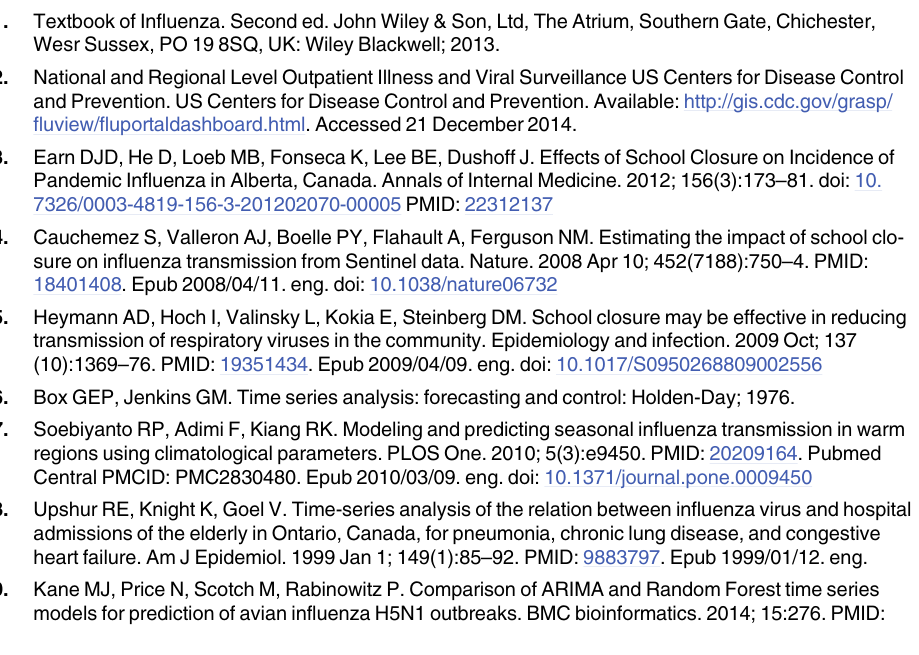
S2 Fig. Last-week ILI rate prediction for HHS region 4. Last-week ILI rate prediction for HHS region 4 was based on previously observed weekly ILI rates and previously fitted last- week ILI rate. A solid blue line represented weekly ILI rates reported by CDC ILInet, a solid red line represented fitted weekly ILI rates. Blue dots and red dots represented the observed and predicted week-52 ILI rates, respectively, with ARIMA models for the following years: a) 2004 last-week prediction by ARIMA( 2 , 0 , 2 ); b) 2006 last-week prediction by ARIMA( 2 , 0 , 2 ); and c) 2008 last-week prediction by ARIMA( 2 , 0 , 2 ).